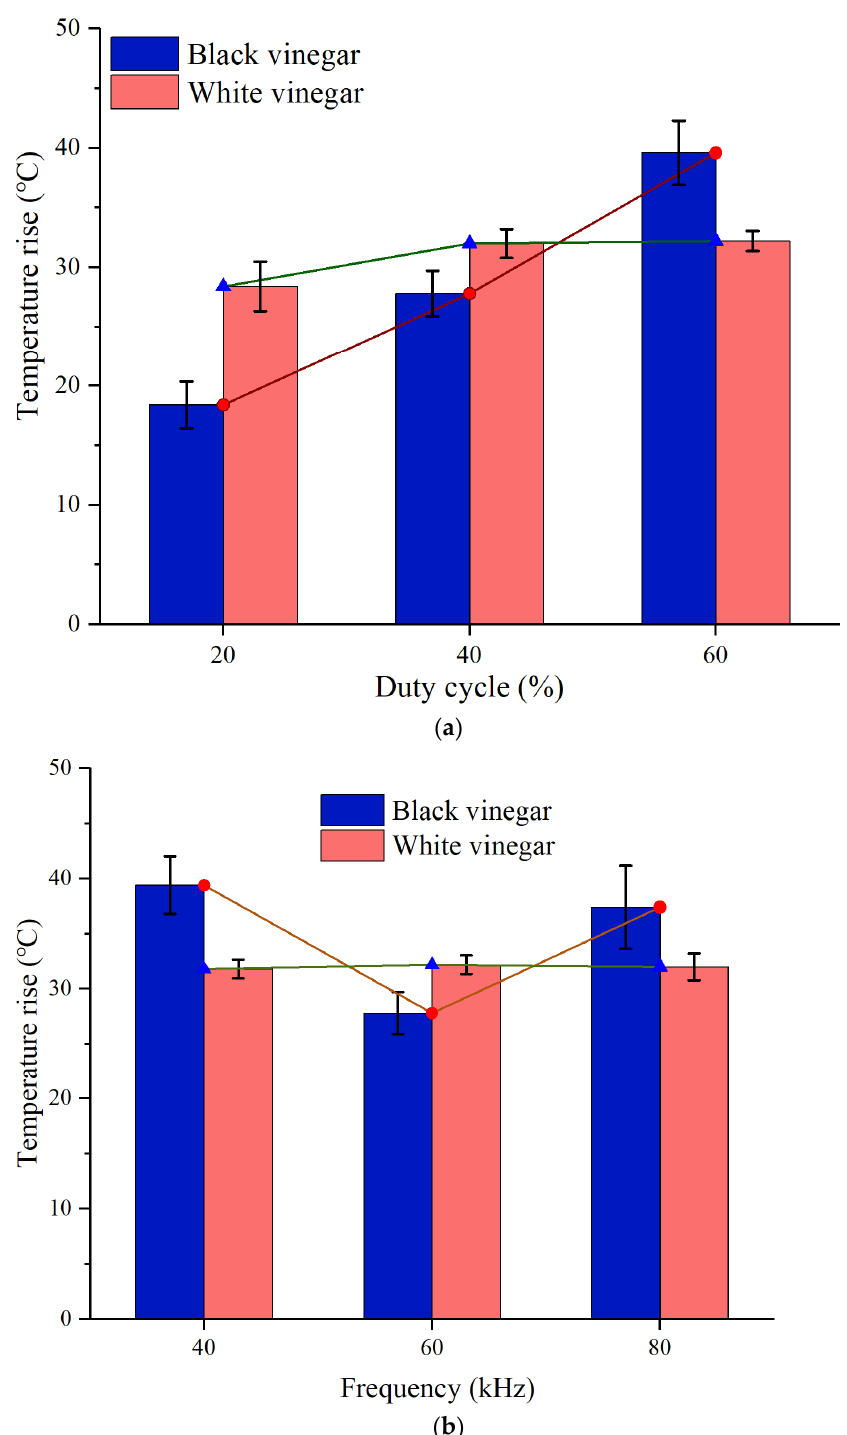
Figure 6. ( a ) Effect of different duty cycle on the temperature rise; ( b ) effect of different frequency on the temperature rise.